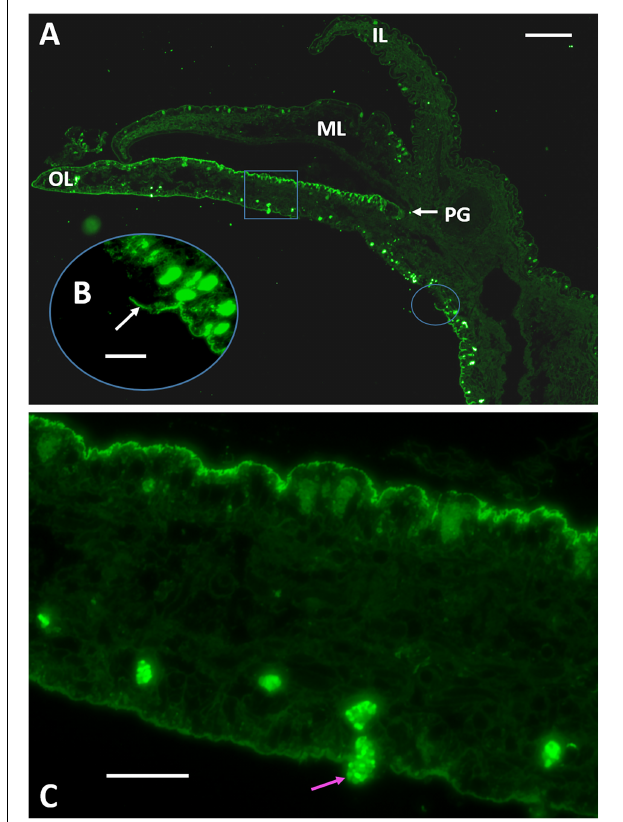
FIGURE 6 | Immuno-fluorescence microscopy of transverse sections of the mantle organ using an anti-48 kDa affinity purified antibody. (A) The mantle edge elaborates into three lobes; the inner lobe (IL) faces the body of the animal and the outer lobe ( OL ) faces the shell and joins to the middle lobe ( ML ) at its base. The space between the OL and ML is termed the periostracal groove. Folian-positive material localizes along the outer lobe epithelium. Scale bar 125 µ m. (B) Oval inset indicated in (A) showing the sheet-like character of the folian material where it is broken and lifted from the epithelium surface (white arrow). Scale bar 40 µ m. (C) Square inset indicated in (A) showing folian positive hemocytes regularly spaced along the length and near the surface of the outer lobe on the shell-facing side. A folian-positive hemocyte is shown moving through the epithelium into the extrapallial cavity (pink arrow). Scale bar 40 µ m. Micrograph in (A) without insets from Johnstone et al. (2008).